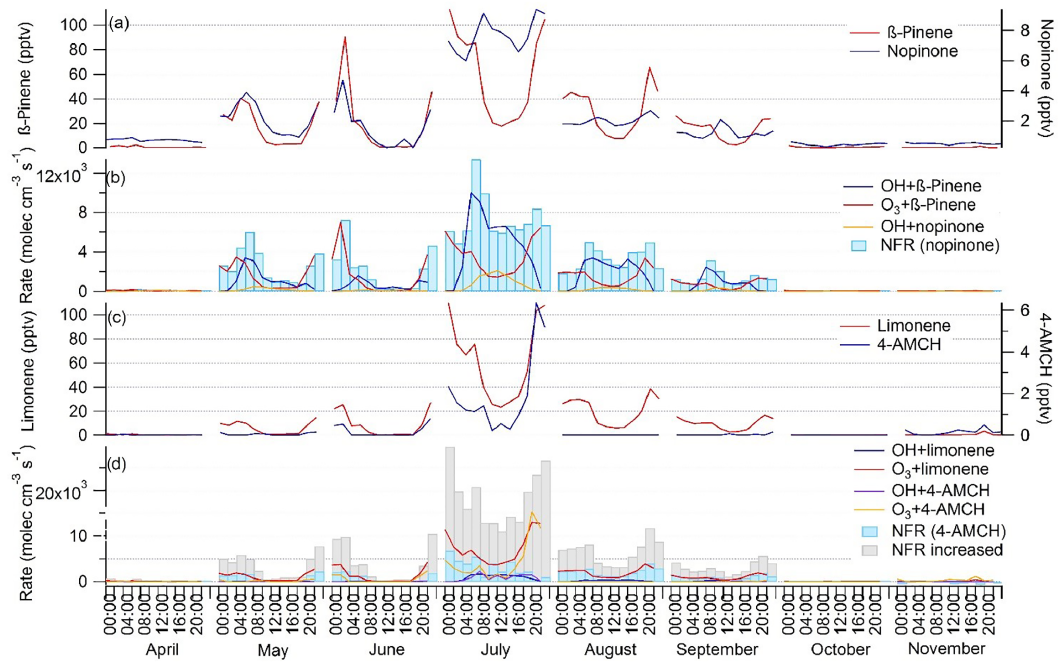
Figure 4. Monthly mean diurnal variation in (a) β -pinene and nopinone concentrations; (b) production rates of nopinone from OH (OH + β - pinene) and O 3 (O 3 + β -pinene) reactions, destruction rate of nopinone by OH reaction (OH + nopinone) and net formation rates (NFR) of nopinone; (c) limonene and 4-acetyl-1-methylcyclohexene (4-AMCH) concentrations; and (d) production rates of 4-AMCH from OH (OH + limonene) and O + limonene) reactions, destruction rates of 4-AMCH by OH (OH + nopinone) and O 3 (O 3 as well as NFR and NFR with increased yields (NFR increased) of